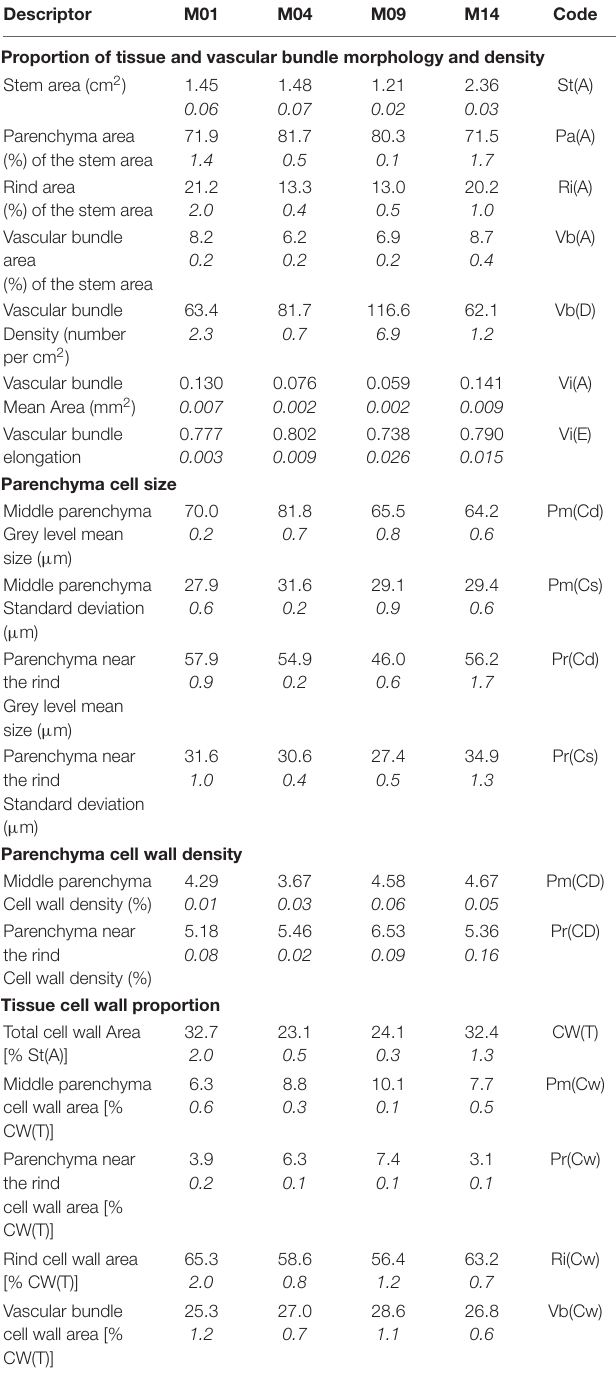
TABLE 3 | Morphological descriptors of the four examples of inbred